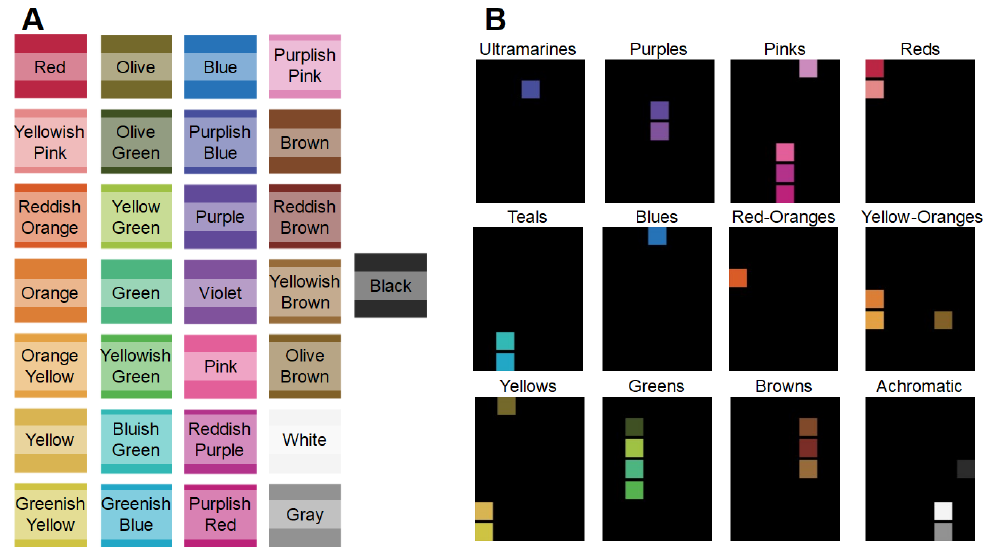
Figure 3. Evaluation of our method with ISCC–NBS system of color categories: ( A ) Level 2 of the ISCC–NBS system, with each color’s name superimposed over its corresponding square; ( B ) ABAN- ICCO classification of image ( A ) into the resulting 12